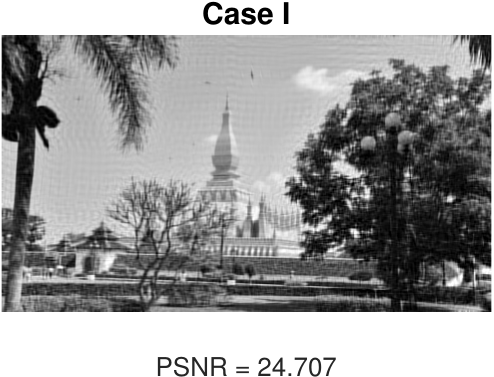
Figure 16. The reconstructed grey image with their PSNRs for three different cases using the proposed algorithm presented in 10,000 iterations,